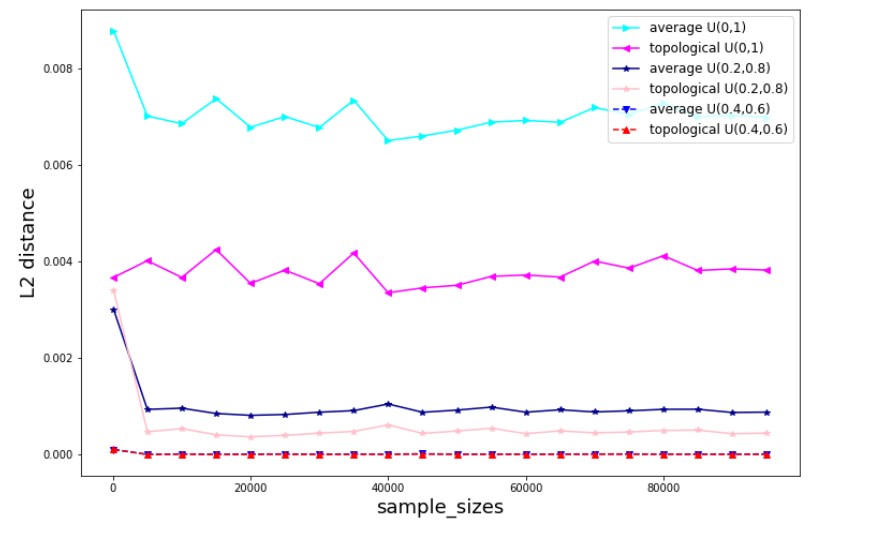
Figure 14. Comparison for different levels of uncertainty of the annotations x i . f ( x ) = x 2